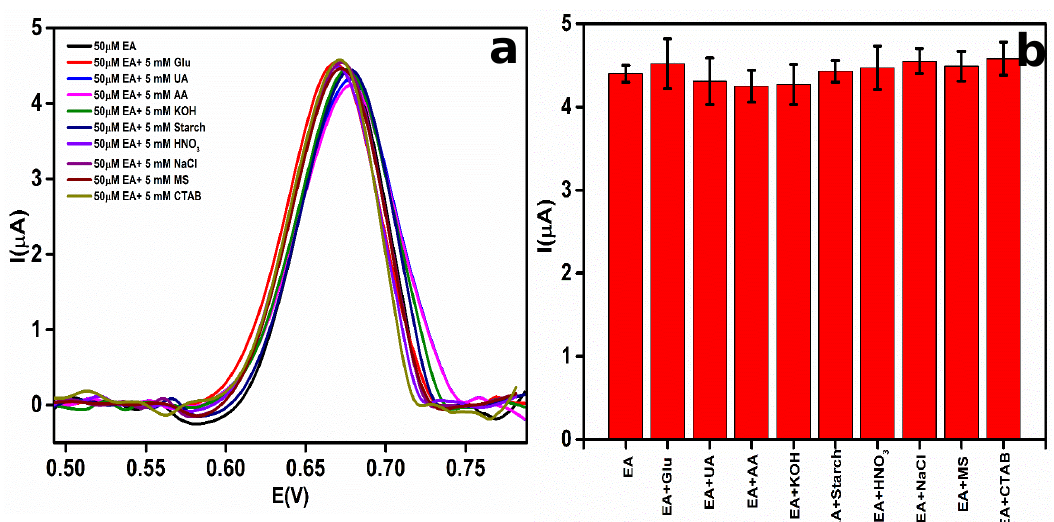
Figure 9. ( a ) Di ff erential pulse voltammetric (DPV) response of an interferent study of etidronic acid (EA) (50 µ M) with di ff erent interferents. ( b ) Bar chart of peak current response of EA with di ff erent interferents.